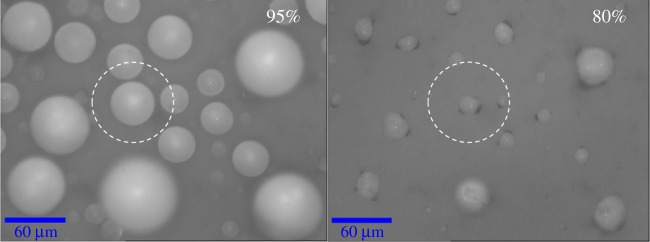
Optical confocal image of 3C droplets exposed initially at 95% RH, ramped down to 80% at 1%/min. The droplets became transparent at 80% RH. (Online version in colour.)